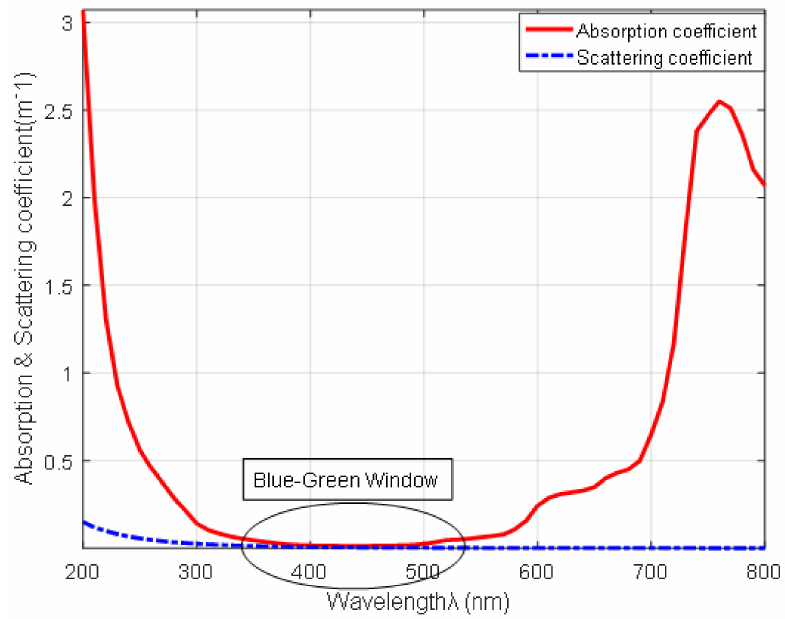
Figure 3. Absorption and scattering coefficients of light in pure